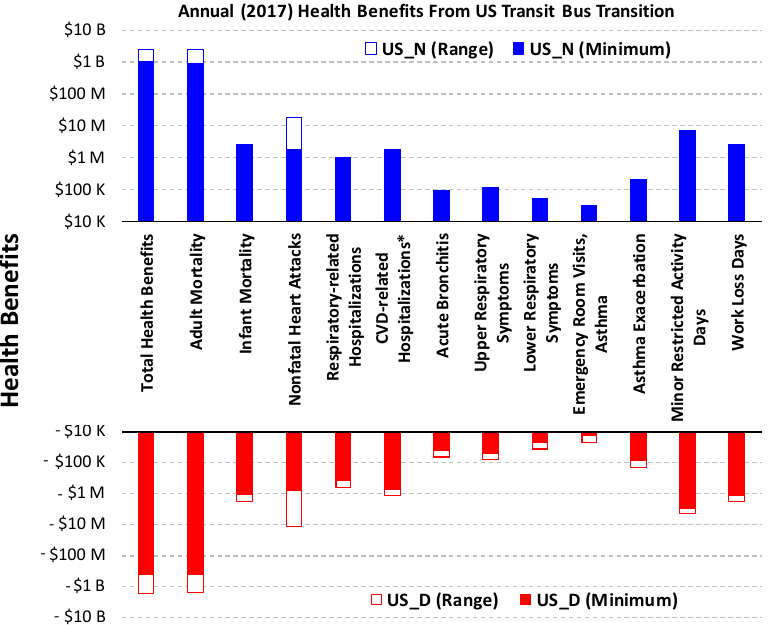
Figure 2. Annual health benefits in economic cost under US_D and US_N. The minimum and range are determined from the lower- and upper-bound estimates with both 3% and 7% discount rate (Supplementary Materials Tables S5–S7). B: Billions: M: millions. K: thousands. * Excluding heart attacks.